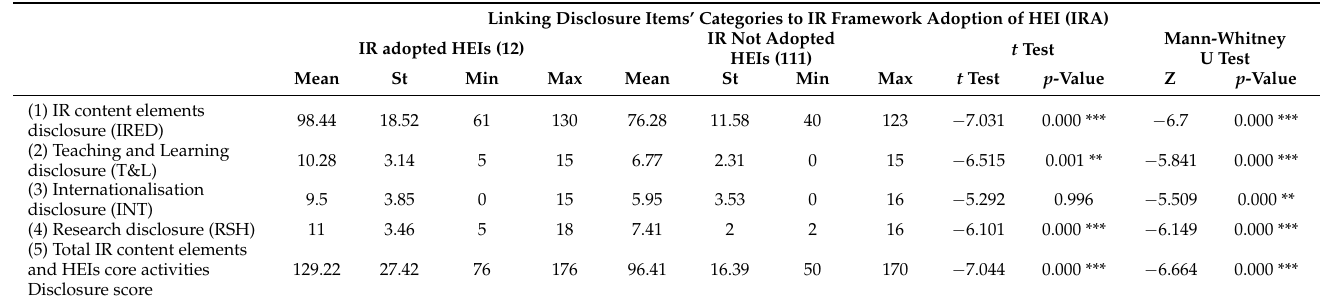
Table 4. Relationship between IR content elements, teaching and learning, internationalisation and research activities disclosure and IR framework